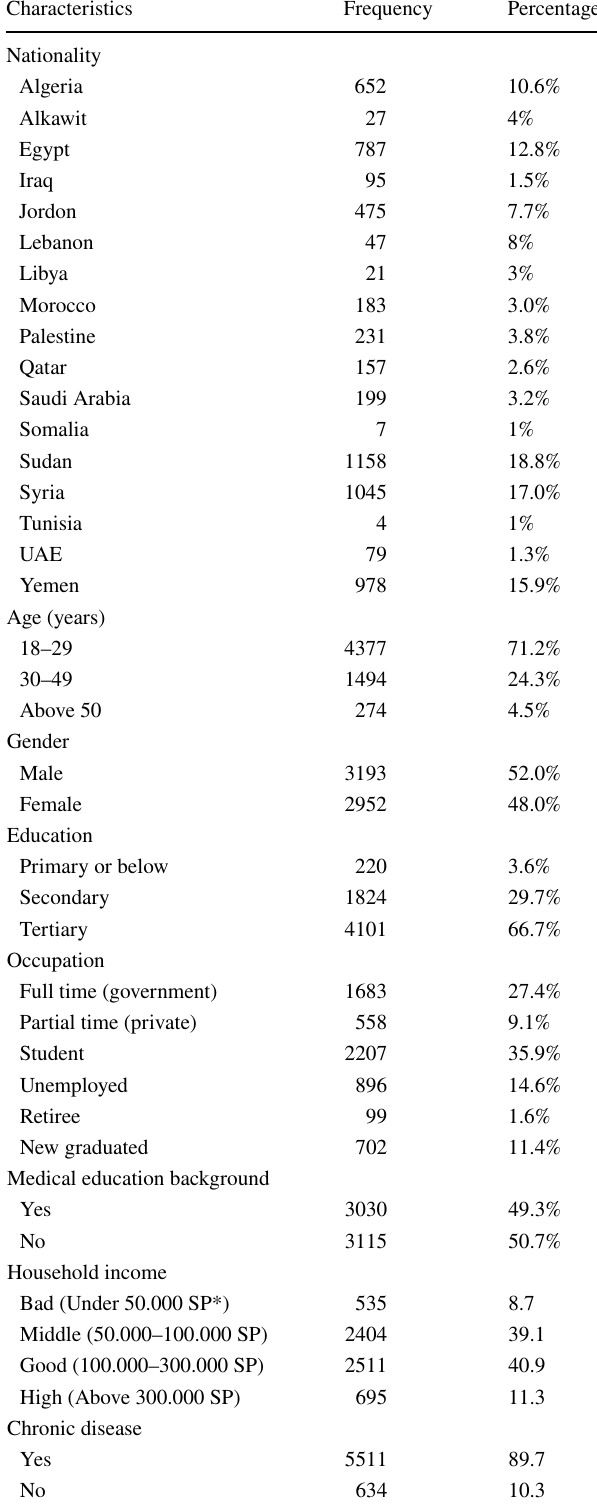
Table 1 Demographic characteristics of the